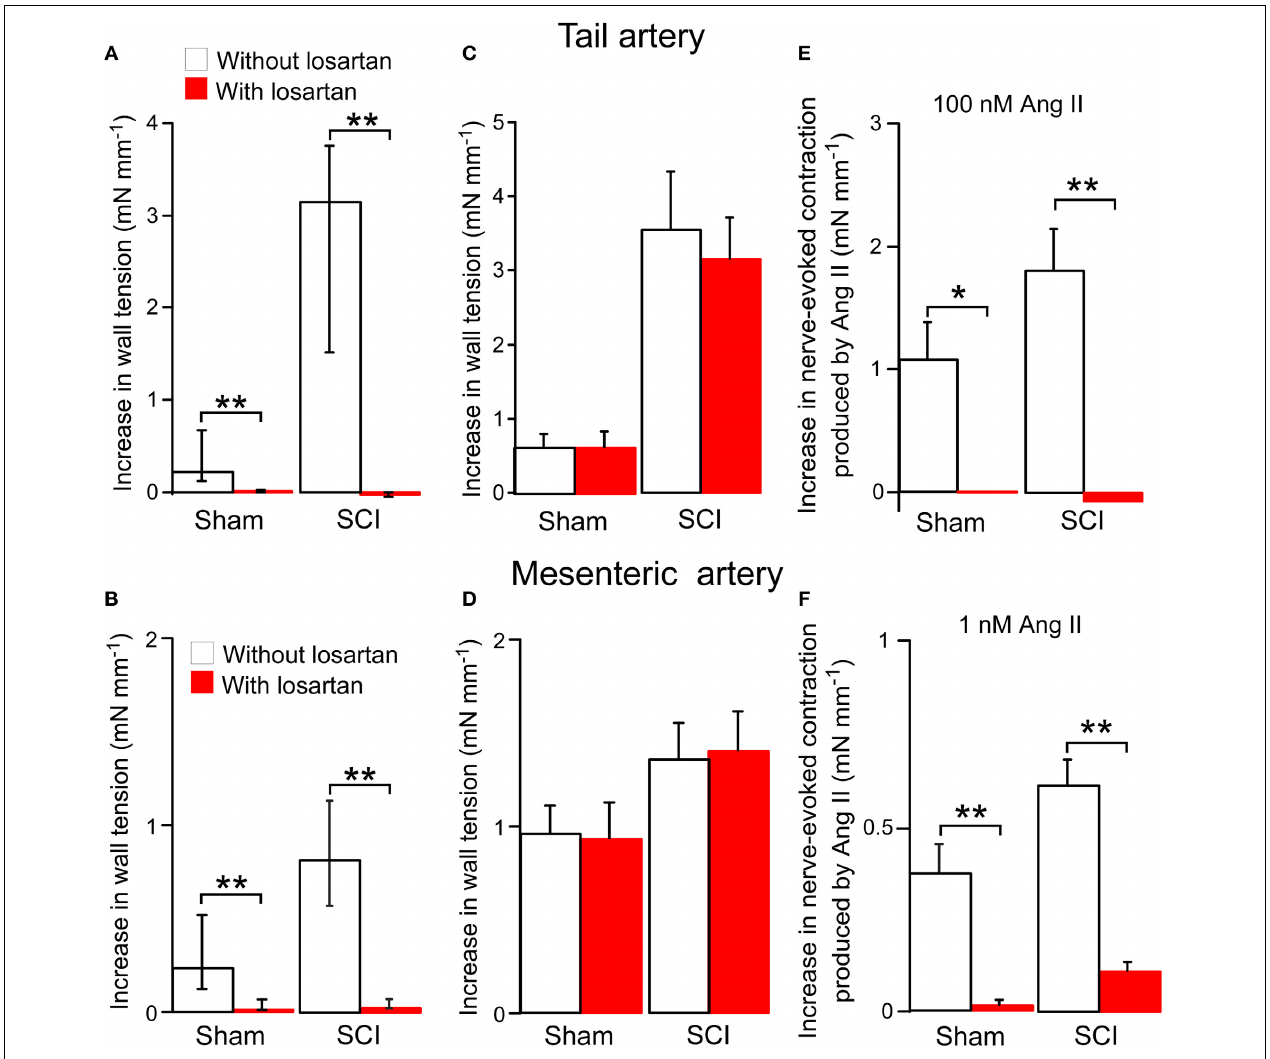
FIGURE 4 | The angiotensin II (Ang II) type 1 receptor antagonist losartan (100nM) blocked both Ang II-evoked contractions and the enhancement of nerve-evoked contractions produced by Ang II in tail arteries and mesenteric arteries from sham-operated and spinal cord injured (SCI) rats. On its own losartan did not change nerve-evoked contractions. (A,B) Peak increases in wall tension produced by 100nM Ang II in tail arteries ( A ; sham-operated n = 8, SCI n = 8) or mesenteric arteries ( B ; sham-operated n = 7, SCI n = 6) in the absence ( white bars ) or in the presence ( red bar ) of losartan. (C,D) Peak increases in wall tension evoked by nerve stimulation (tail artery: 5 stimuli at 0.5Hz; mesenteric artery: 20 stimuli at 10Hz) before ( white bar ) and during ( red bar ) application of losartan in tail arteries ( C ;